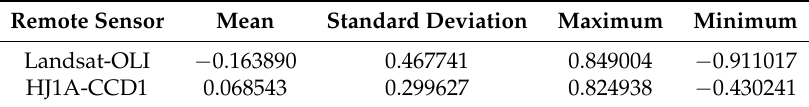
Table 7. Statistical results of Landsat-OLI and HJ1A-CCD1 NDVI